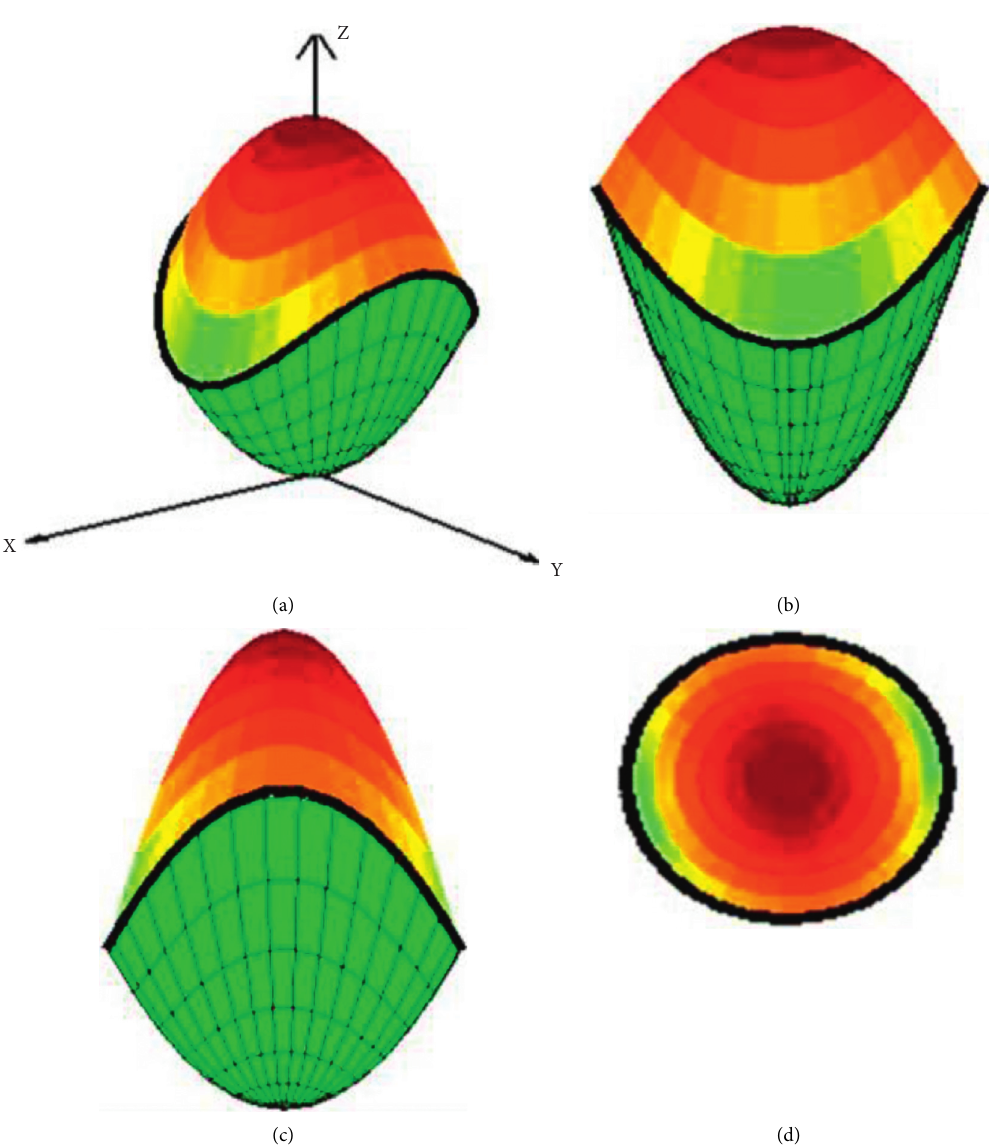
Figure 11: Actual effect graphics drawn by Matlab: (a) stereoscopic view, (b) front view, (c) side view, (d) top